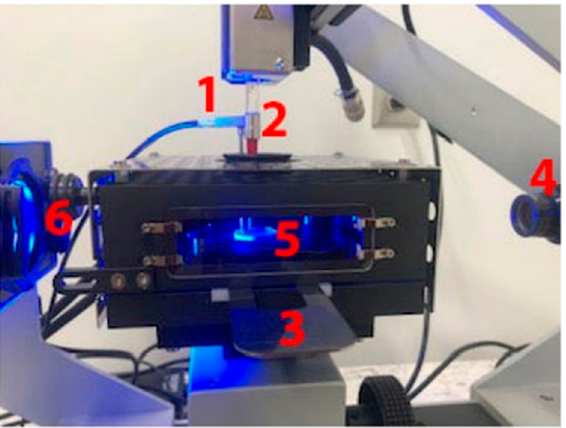
Figure 1. Drop shape analyzer used for static contact angle and penetration time measurement. (1): temperature probe, (2): 500 μ L syringe, (3): compressed powder holder, (4): high-speed camera, (5): temperature- and humidity-controlled chamber, (6): light source. Image take from KRÜSS ® drop shape analyzer.